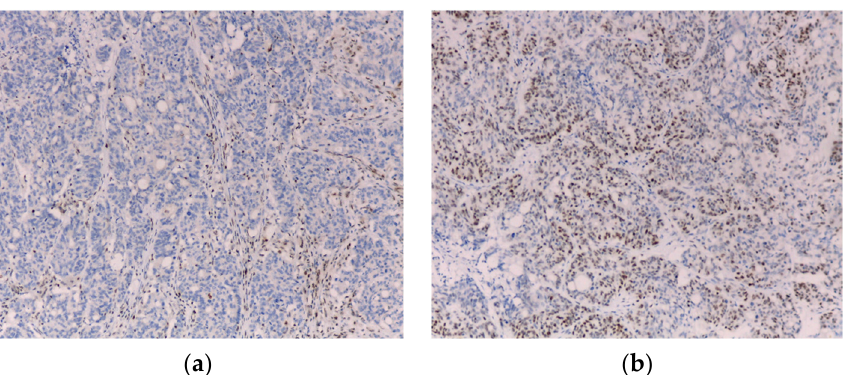
Figure 1. Immunohistochemistry showing loss of MLH1 ( a ) and maintained MSH2 ( b ) staining (10 ×).